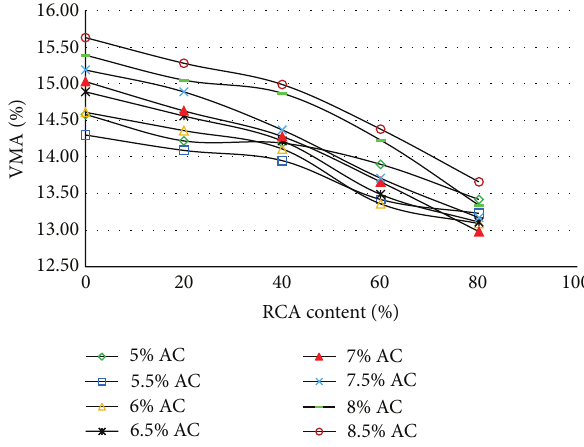
Figure 5: VMA values versus RCA content for each percentage of asphalt